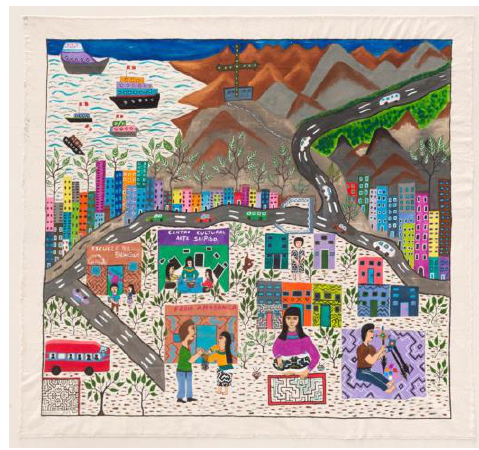
Figure 4. Elena Valera, La comunidad Shipibo-Conibo de Cantagallo (Lima) , 2012, acrylic paint on cloth, 118 cm × 110 cm. Photo credit: Juan Pablo Murrugarra. Courtesy of MAC Lima.